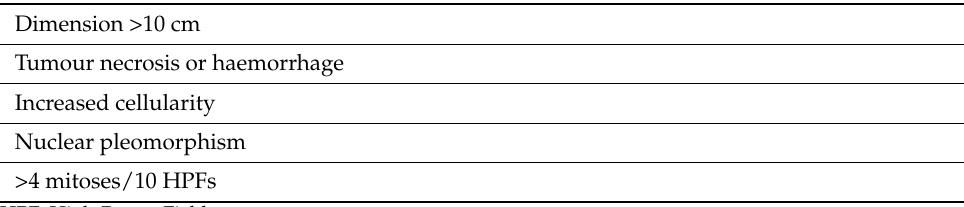
Table 2. England’s criteria of malignancy